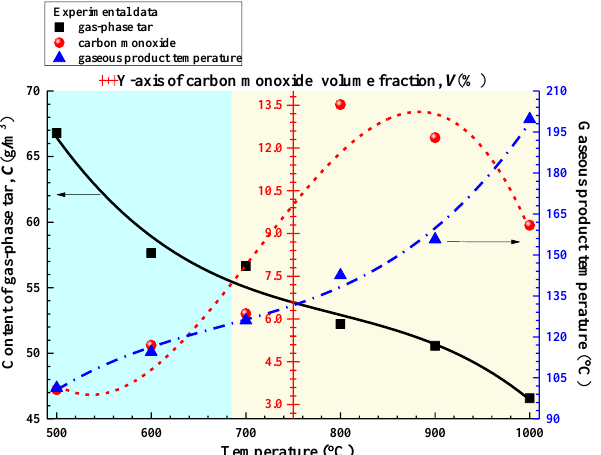
Processes 2022 , 10 , x FOR PEER REVIEW Figure 13. Variation of gas-phase tar content, CO volume fraction, and gaseous product temperature with the pyrolysis temperature under the flow volume ratio of Brown’s gas to nitrogen of 1%. Therefore, the turning point of acceleration and deceleration of CO production rate was located at the pyrolysis temperature of T = 750 °C. From the Figure 14, when the vol- ume flow rate of Brown’s gas increased, the overall average level of gas -phase tar content and gaseous product temperature ( T KN ) decreased, and the overall level of CO volume fraction increased significantly. Compared with the Figure 13, the rise rate of gaseous product temperature ( T KN ) decreased obviously. In the pyrolysis temperature range of T = 500 °C~700 °C, the cracking rate of gas-phase tar was larger, while the rise rate of gaseous product temperature ( T KN ) was smaller. When the pyrolysis temperature was T > 700 °C, the cracking rate of gas-phase tar decreased, while the rise rate of gaseous product tem- perature ( T KN ) increased. The turning point of the acceleration and deceleration of CO pro- duction rate was located at the pyrolysis temperature of T = 700 °C, and the position of turning point moved forward with the increasing the flow volume ratio of Brown’s gas to nitrogen.